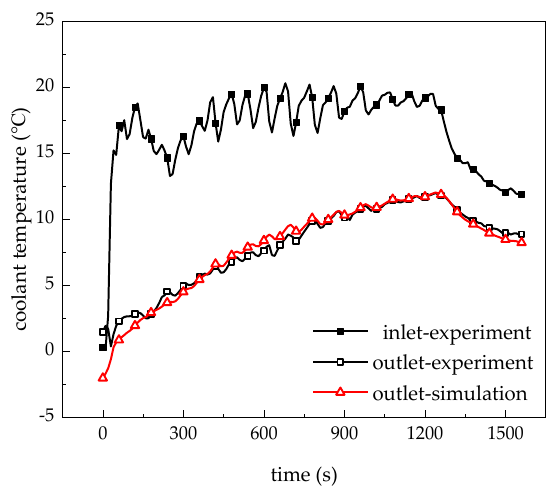
Figure 5. Coolant temperatures at inlet and outlet in experiment and simulation.